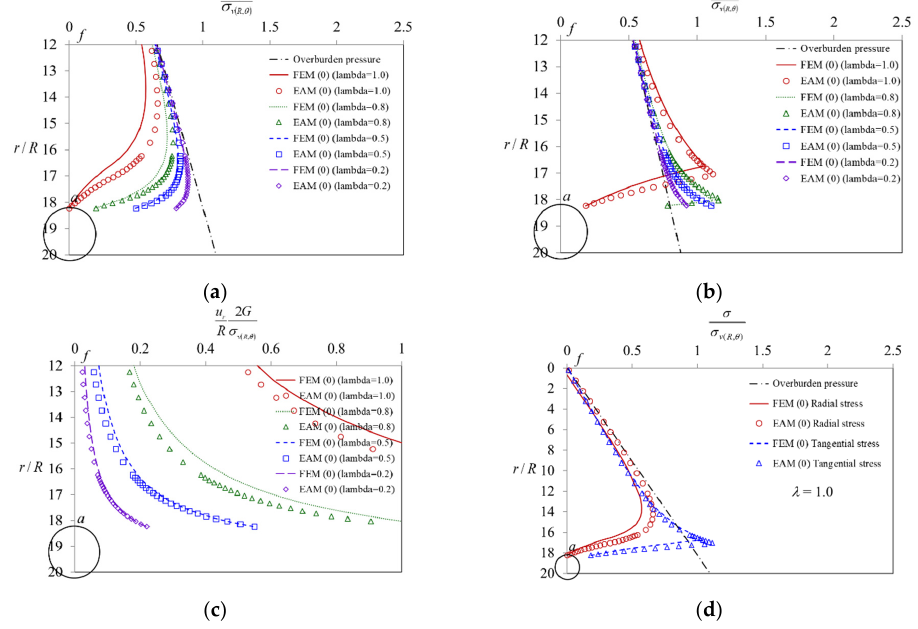
Figure 15. Ground reaction around the tunnel obtained by EAM and FEM with the different incre- mental values λ in an elastoplastic media, and the distribution of ( a ) radial stress, ( b ) tangential stress, ( c ) radial displacement, and ( d ) tangential and radial stresses with λ = 1.0 (Case I, θ = 0°, along the ground surface line and K o = 0.8). In addition, in Case III (the area below the spring line, 90° < θ < 180°), it supposes that a distance r is along the vertical line ej and the initial stress equals 2 γ ( h + R ). Figures 16 and 17 show the analysis results in the elastic region and in the elastoplastic region, re- spectively. As for the expression of stress anisotropy and the influence of overburden depth, it can be determined from (d) in Figures 14–17 that the overburden pressure line can be represented by the distribution diagram of the radial stress line. In other words, the influence of two factors, overburden depth and stress anisotropy, can be described by using the tunnel radial stress distribution map.